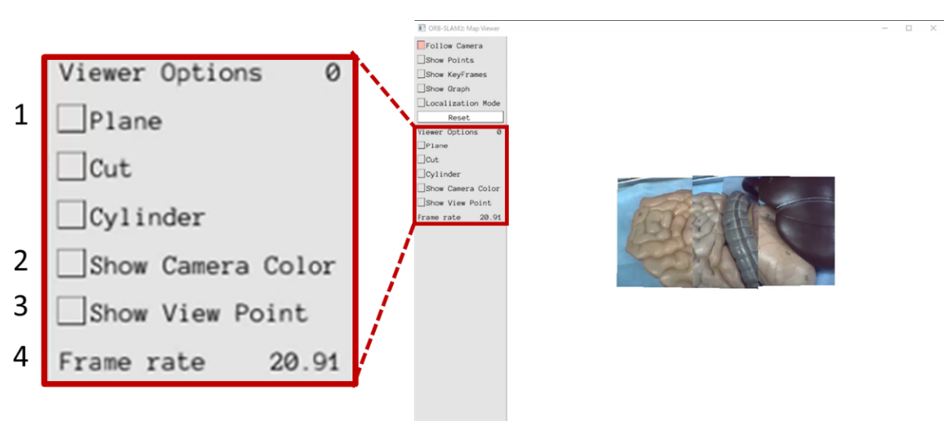
Figure 13. User interface for expanded view